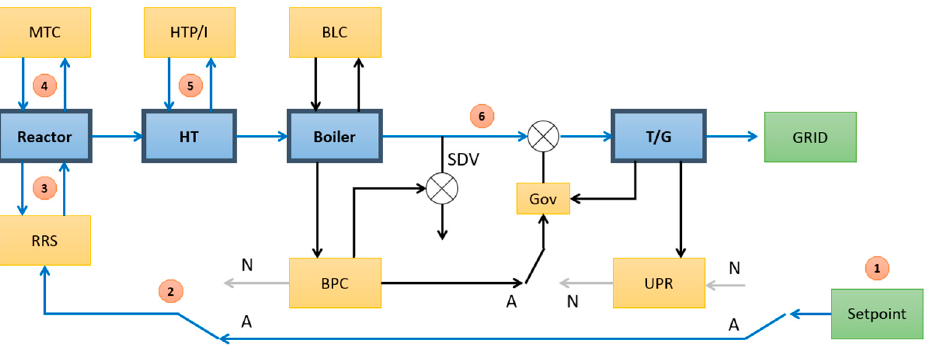
Figure 4. Modes of an NPP’s operation—alternate mode.